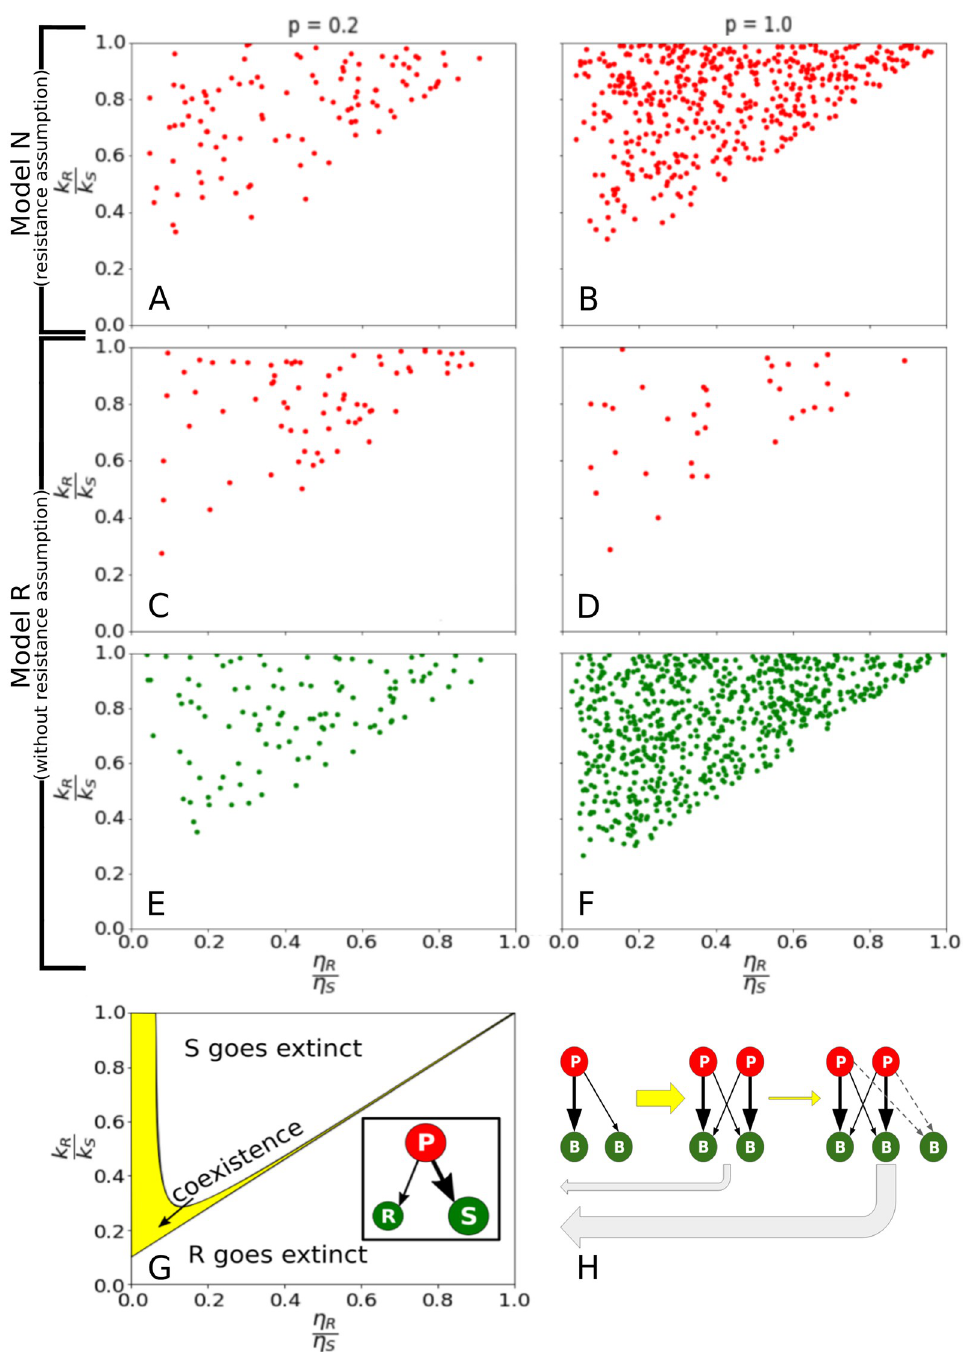
Fig 3. Extinction events. (A-F) Elimination of the fastest grower (S) by a slower-growing bacterial strain (R), using one common phage. The x -axis show ratio η R / η S of infection rates to the bacterial strain, while y -axis marks the ratio k R / k S of growth rates. Red dots mark events initiated by a phage while green dots mark events initiated by new a bacterial strain. (G) Analytically calculated regions of coexistence and extinctions for the above system (see S1 Appendix). The insert shows the motif with growth rates marked by circle size and susceptibility by the thickness of arrows. The yellow region marks the coexistence of all three strains. (H) Illustration of the evolution of the network as strains are added. Extinctions (grey arrows) are more likely as the system